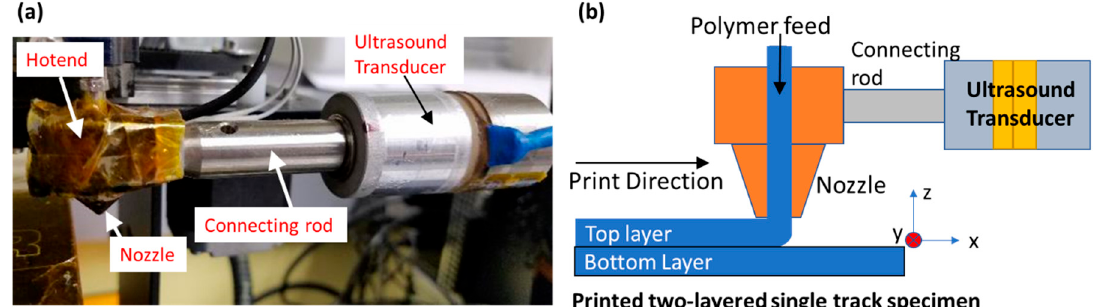
Figure 1. Laboratory-implemented apparatus for incorporating ultrasonic vibrations into Fused Filament Fabrication (FFF)-deposition of thermoplastic polymer. ( a ) photogragh of actual apparatus. ( b ) Conceptual sketch.